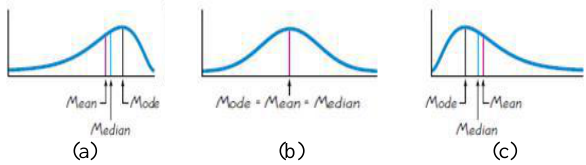
Figure 4. Normality of data (a) negative skewness (median and mean tends to the right), (b) zero skewness (median, mean, mode and the same), and (c) positive skewness (median and mean tends to the